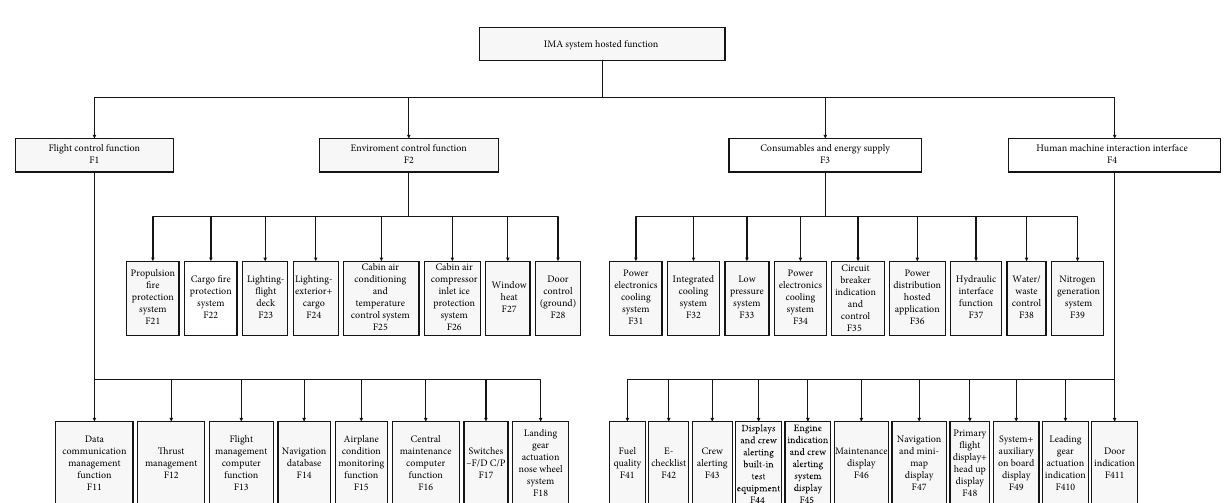
Figure 3: Function safety criticality assessment and grading system of B787 IMA.